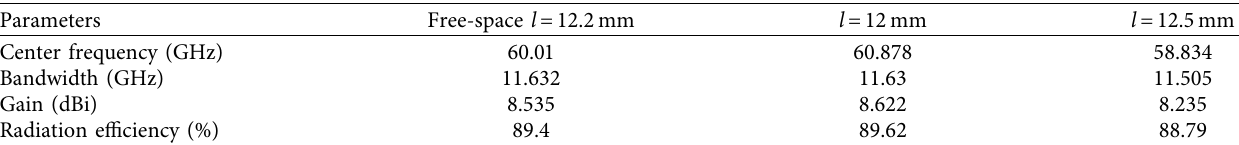
Figure 7: Return loss for change in antenna length “ l. ” Table 4: Antenna length